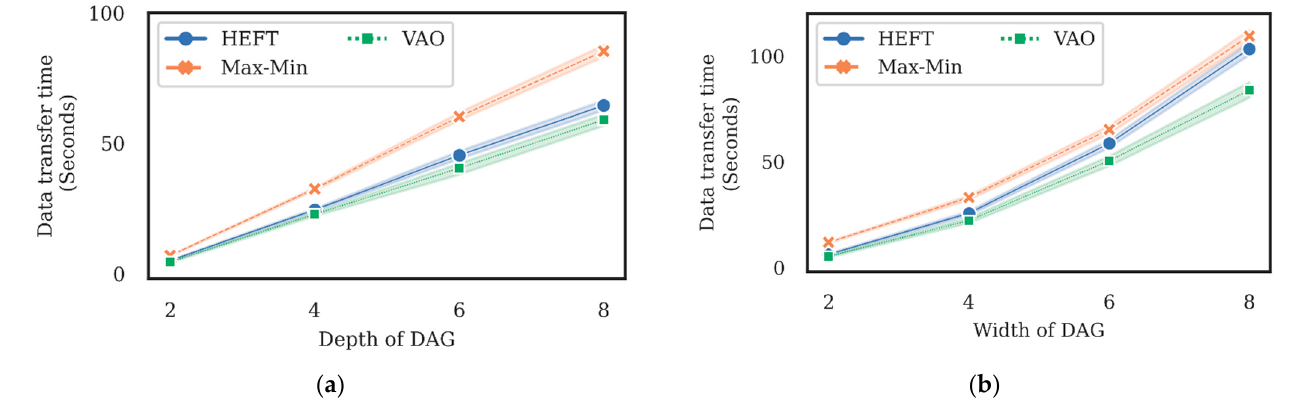
Figure 9. Data transfer time with varying depth and width of DAG: ( a ) Data transfer time against the depth of DAG; ( b ) Data transfer time against the width of DAG.